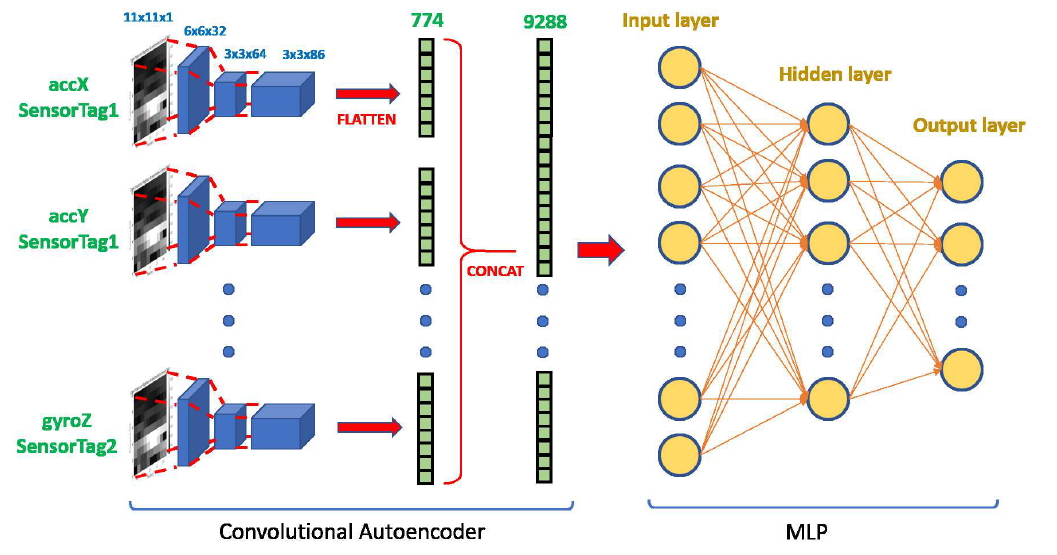
Figure 3. The complete classifier architecture.